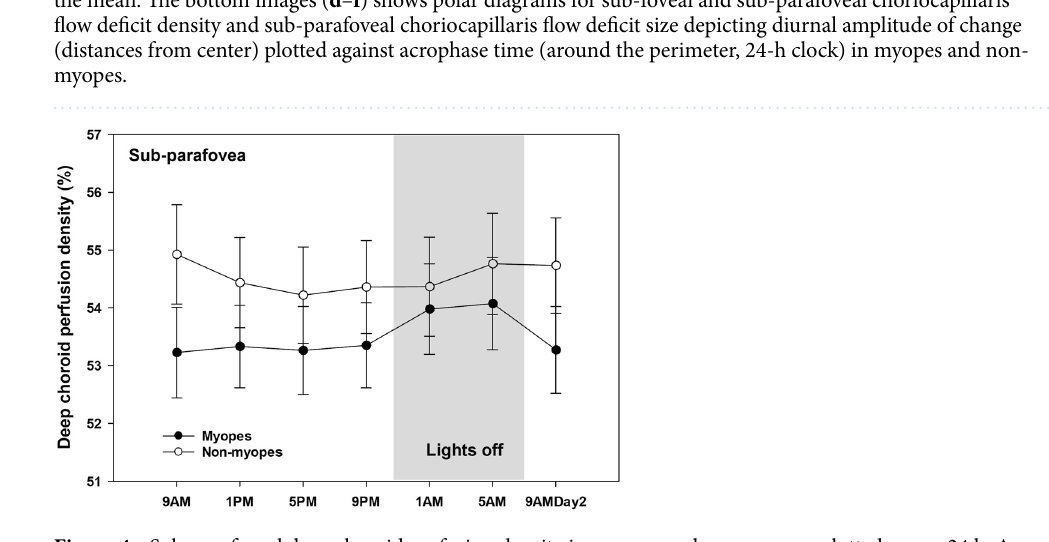
Figure 4. Sub-parafoveal deep choroid perfusion density in myopes and non-myopes plotted across 24 h. A significant time by refractive group interaction for both indices (P = 0.03) was noted with myopes and non- myopes demonstrating different pattern of variation, however their acrophase difference did not reach statistical significance. Error bars indicates one standard error of the mean for all time